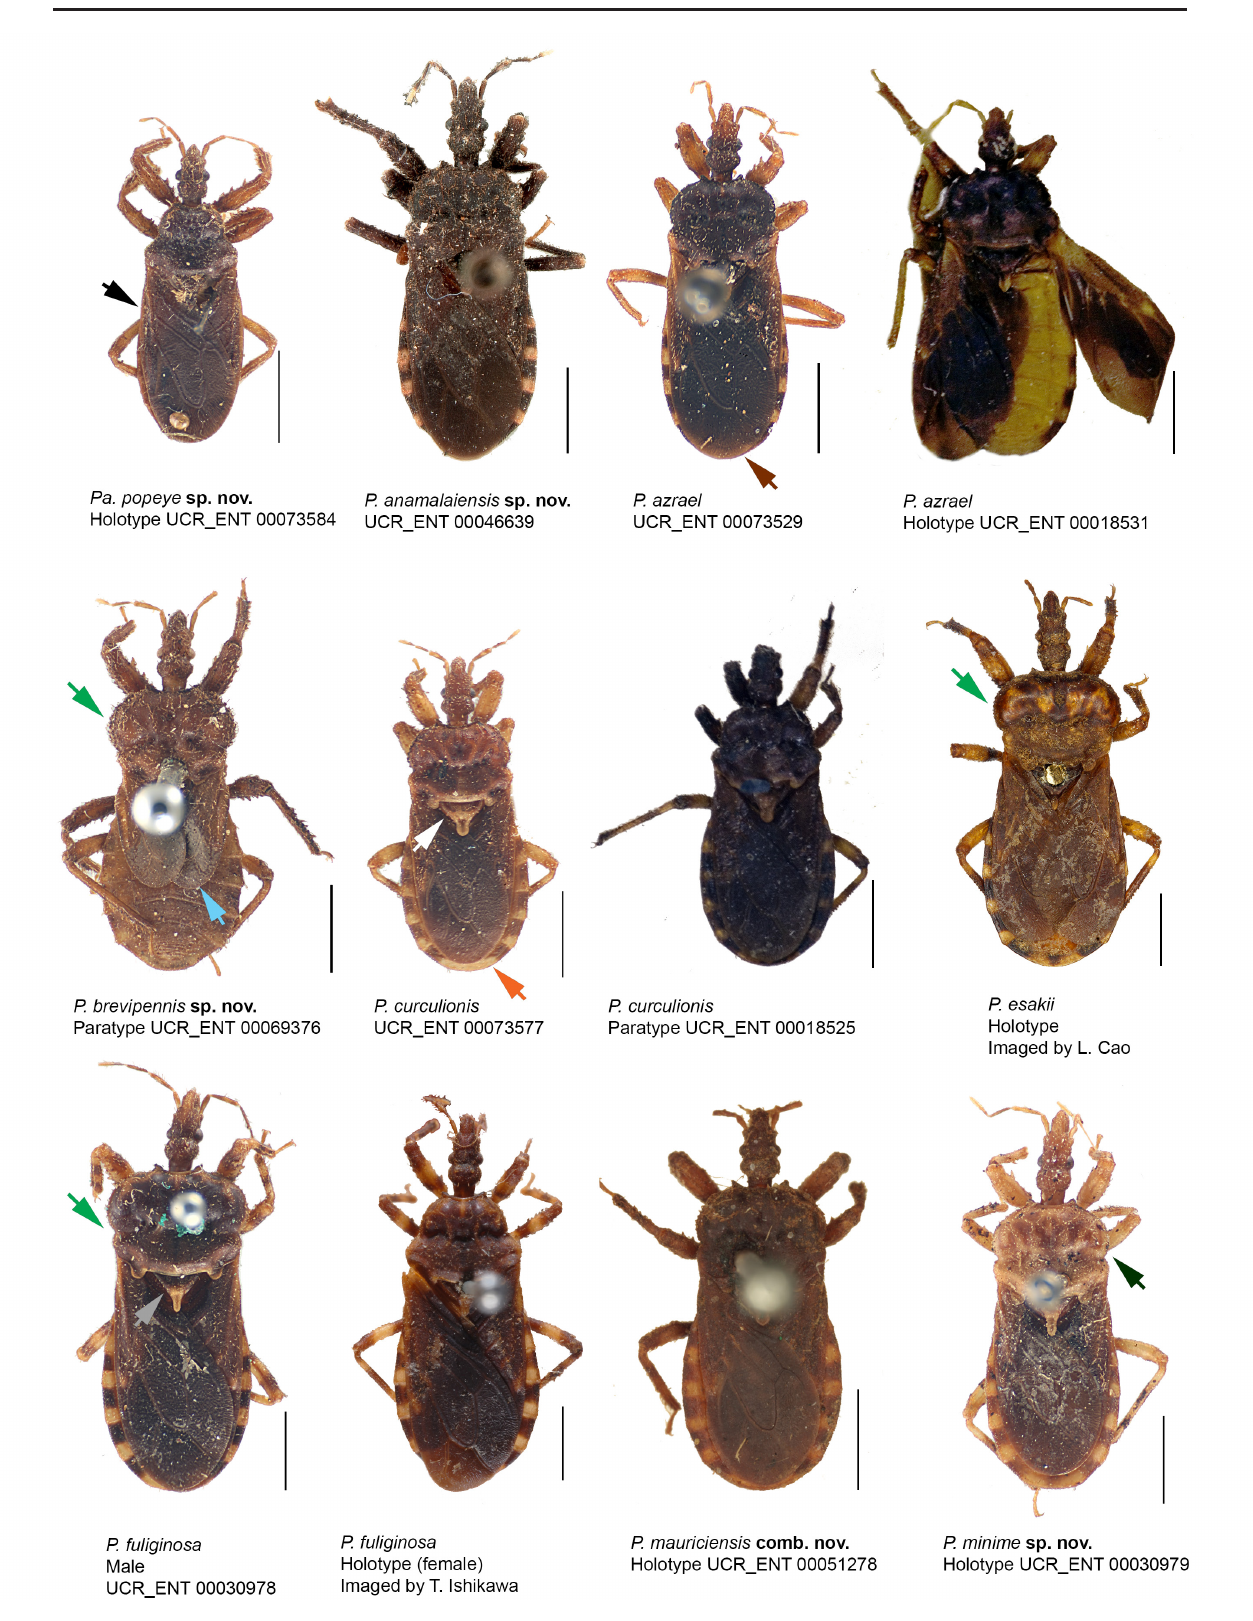
Fig. 14. Dorsal habitus images for species of Paraphysoderes Villiers, 1962 and Physoderes Westwood, 1845 (partial). For an explanation of the colored arrows, see keys on page 63 and 66. Scale bars = 2